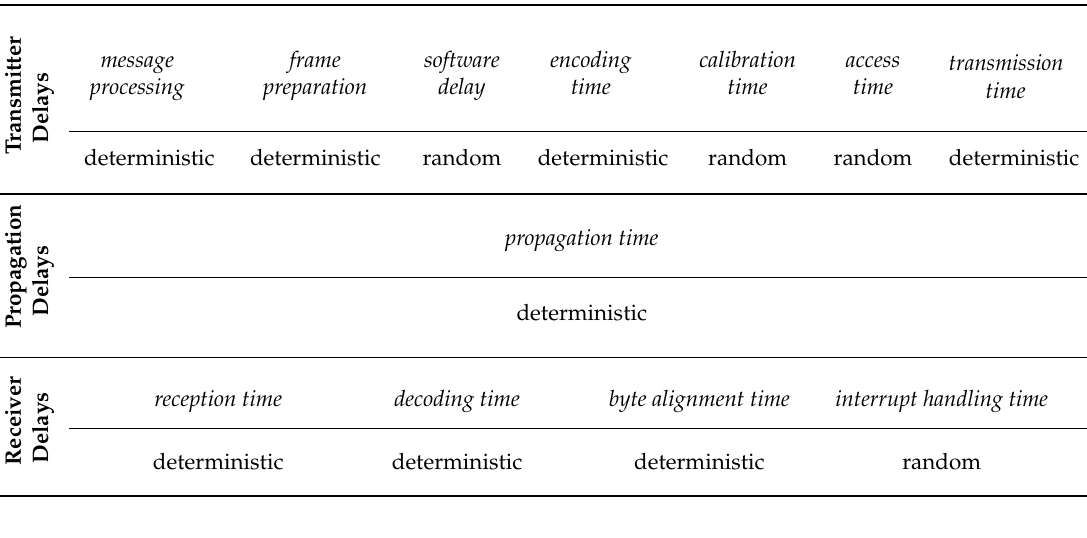
Table 8. Messaging error